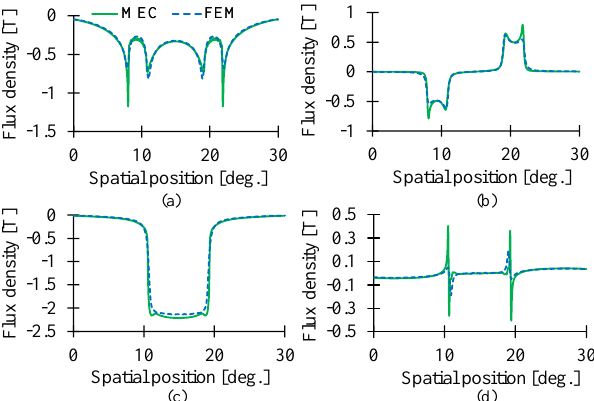
Figure 14. Airgap flux density waveforms at 60 A static excitation current: ( a ) radial flux density at the unaligned position, ( b ) tangential flux density at the unaligned position, ( c ) radial flux density at the aligned position, and ( d ) tangential flux density at the aligned position.